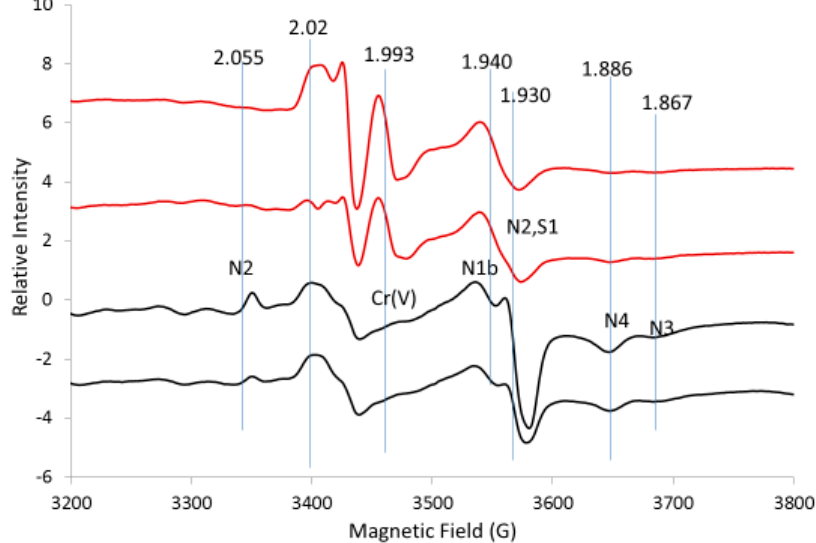
Figure 3. EPR spectra for control liver tissue (black) versus tissue treated with chromate (red). The vertical lines indicate the g-values for EPR lines from Complex I (N2, N1b, N3, N4) and Complex II (S1) discussed in the text. Spectrometer conditions: microwave frequency, 9.632 GHz; temp., 10 K;